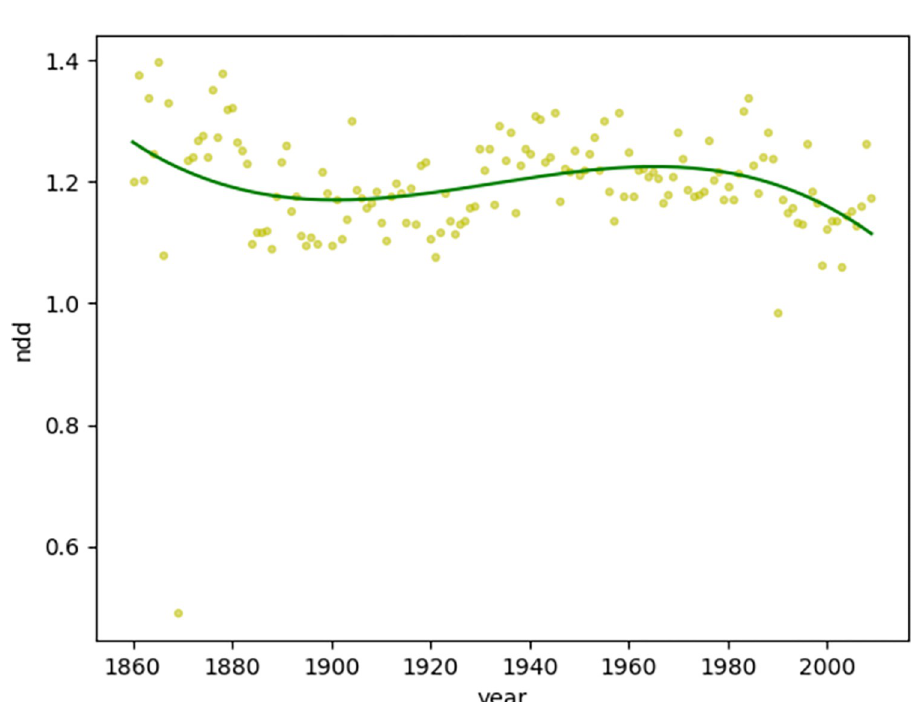
Fig 7. Diachronic non-linear distribution of NDD for news texts.